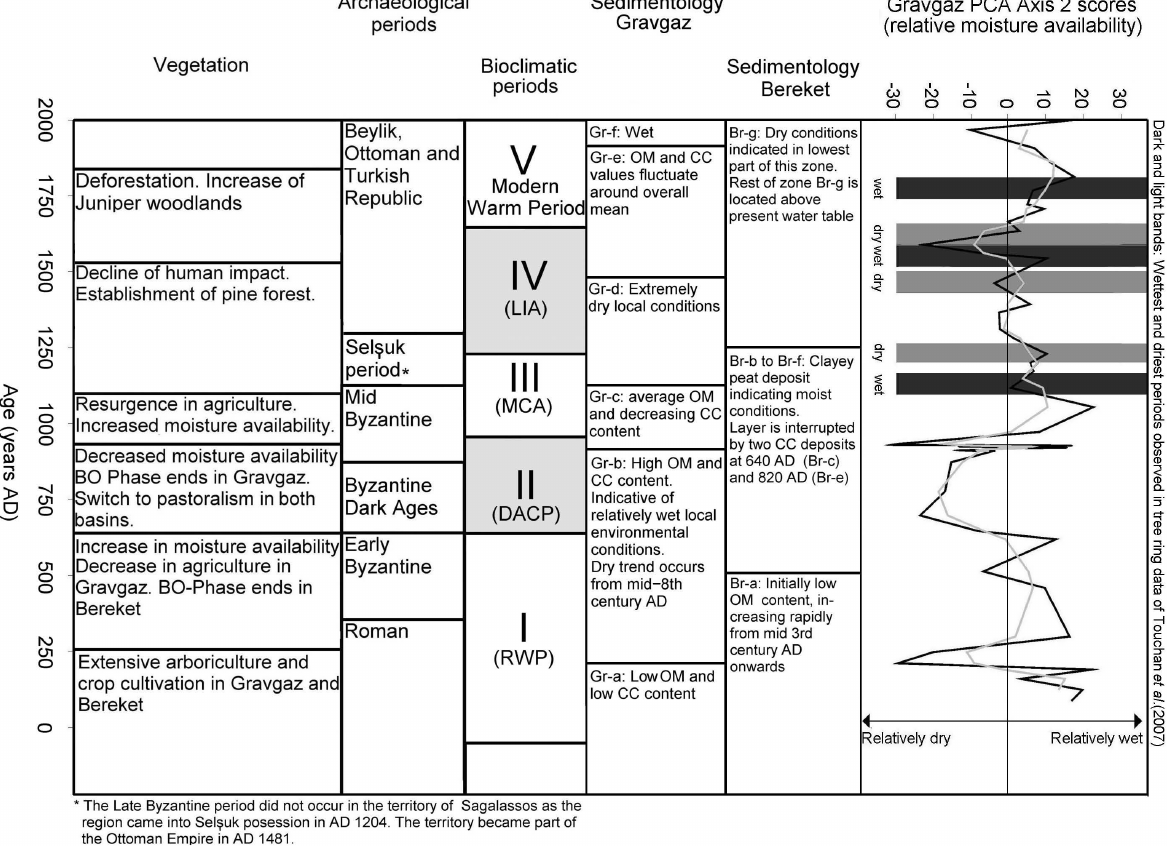
Fig. 8. An overview of the main changes in the vegetation and environmental conditions in the territory of Sagalassos, the main archaeological periods, the main climatic periods and the bioclimatic proxy for the territory of Sagalassos (Bakker et al., 2012) with the most extreme dry and wet periods detected by Touchan et al. (2007) superimposed. The subdivision into historical periods is based on Vanhaverbeke and Waelkens